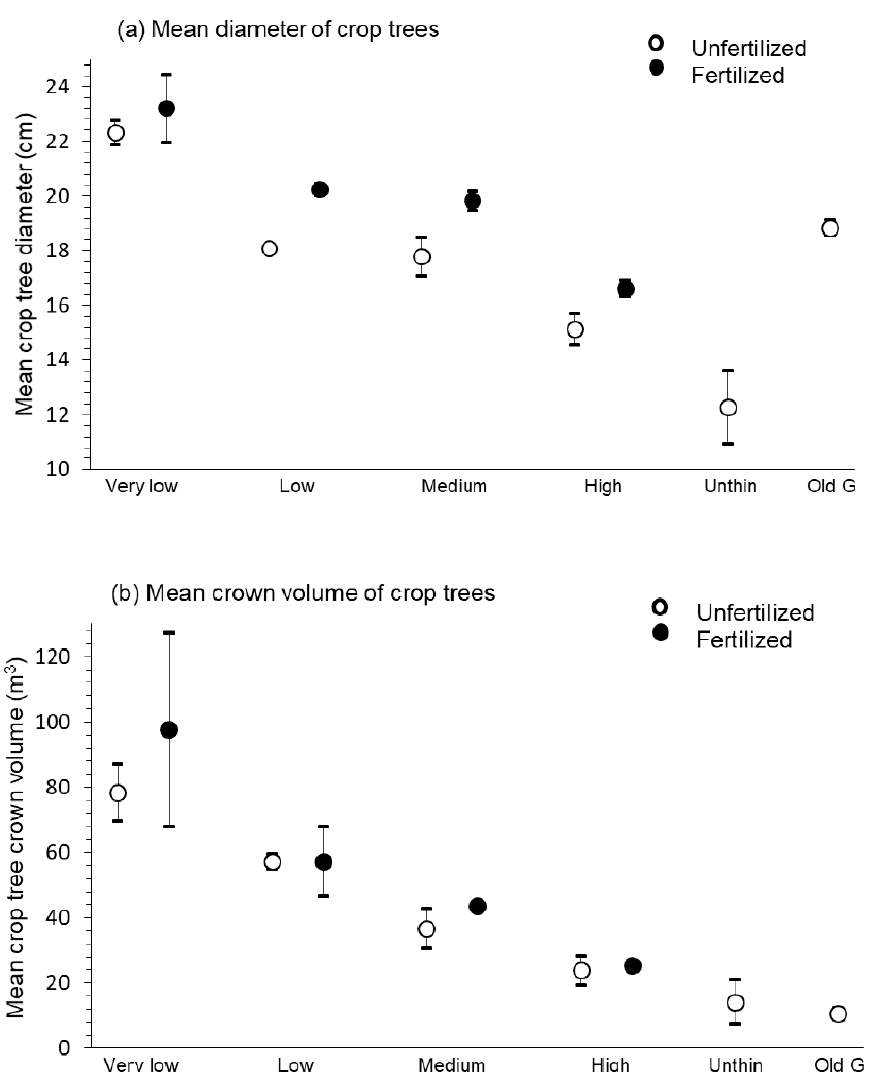
Figure 3. Mean ( n = 2, 3 replicate study areas; ± SE) ( a ) diameter (cm) and ( b ) crown volume (m 3 / tree) of crop trees in the very low-, low-, medium-, and high-density stands of lodgepole pine with and without fertilization, and unthinned (Unthin) and old-growth (Old G) stands, 25 years after initiation of treatments.